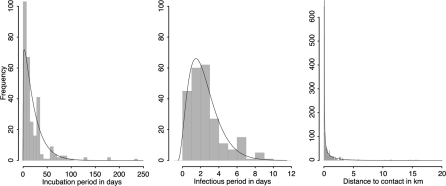
Observed Frequency Distributions of Important Epidemiological Parameters(A) The incubation period, (B) the infectious period, and (C) the spatial infection kernel. The best fitting gamma distributions to the data are shown by black lines (see Materials and Methods).